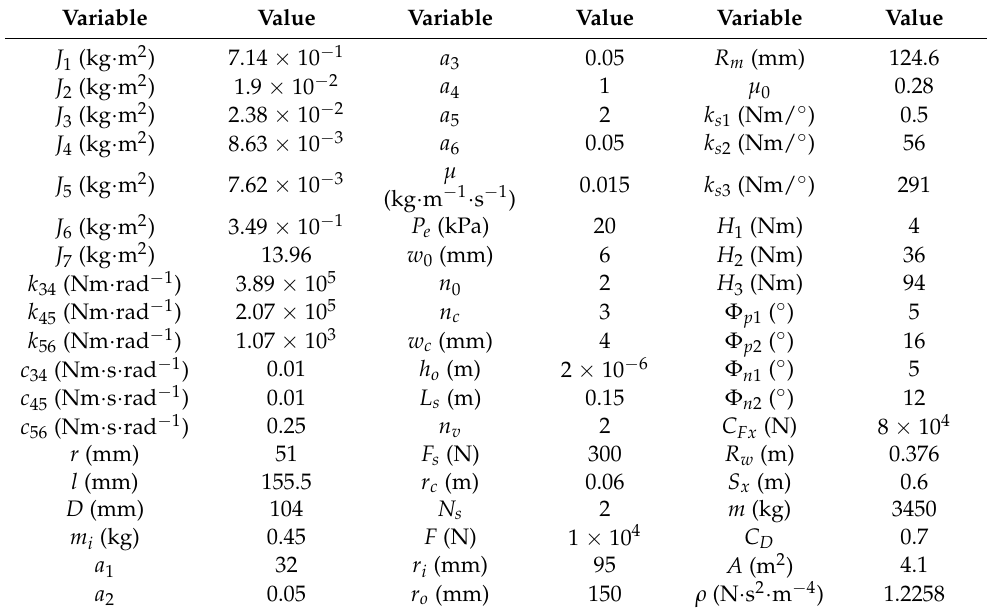
Table A1. Variables and Values of dynamic model